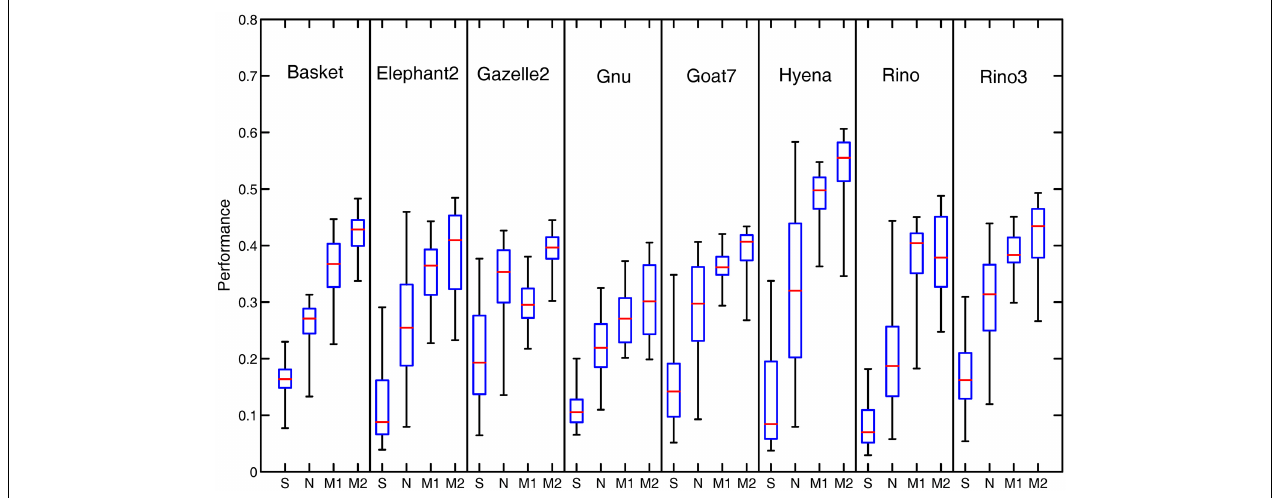
FIGURE 7 | Box-and-Whisker statistical comparison of different models. The Box-and-Whisker plots compare the performance of the orientation-selective inhibition model (denoted by OS), non-selective inhibition model (denoted by NS), our Model 1 (denoted by M1) and